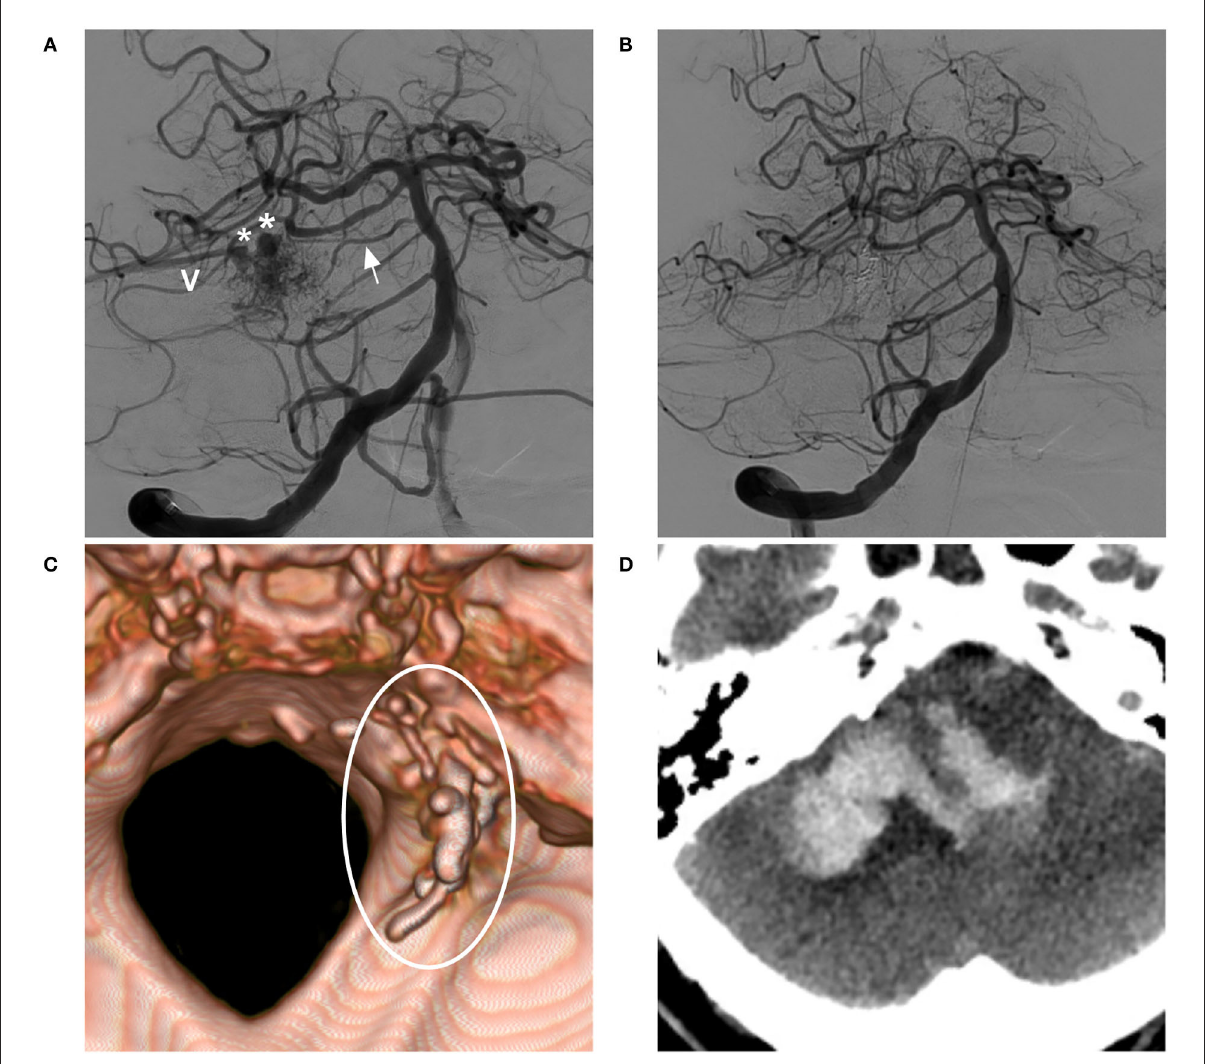
FIGURE6 BAVM with post-operative venous rupture (case 13). (A) Angiogram of the VA showing the BAVM supplied by the SCA and pontine branch (arrow), with two venous aneurysms (asterisks) on the draining vein (V). (B) Post-operative angiogram showing complete embolization of the BAVM and not showing the draining vein. (C) Post-operative CT reconstruction showing Onyx casting (circle). (D) Post-operative CT showing venous hemorrhage away from the nidus. BAVM, brain arteriovenous malformation; CT, computed tomography; VA, vertebral